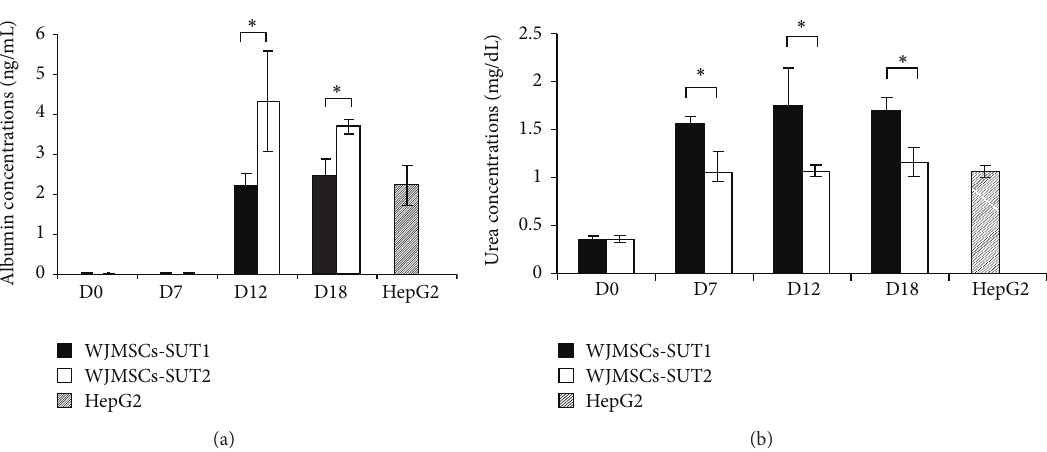
Figure 6: The capacities of the differentiated cells to secrete albumin and produce urea after induction for 18 days. Albumin secretion (a) and urea production (b) of MSCDHCs generated from WJMSCs-SUT1 and WJMSCs-SUT2 were determined by ELISA and colorimetric assay following the differentiation period, respectively. HepG2 was used as positive control. All data are presented as mean ± SD ( 𝑛 = 3 ). ∗ 𝑃 < 0.05